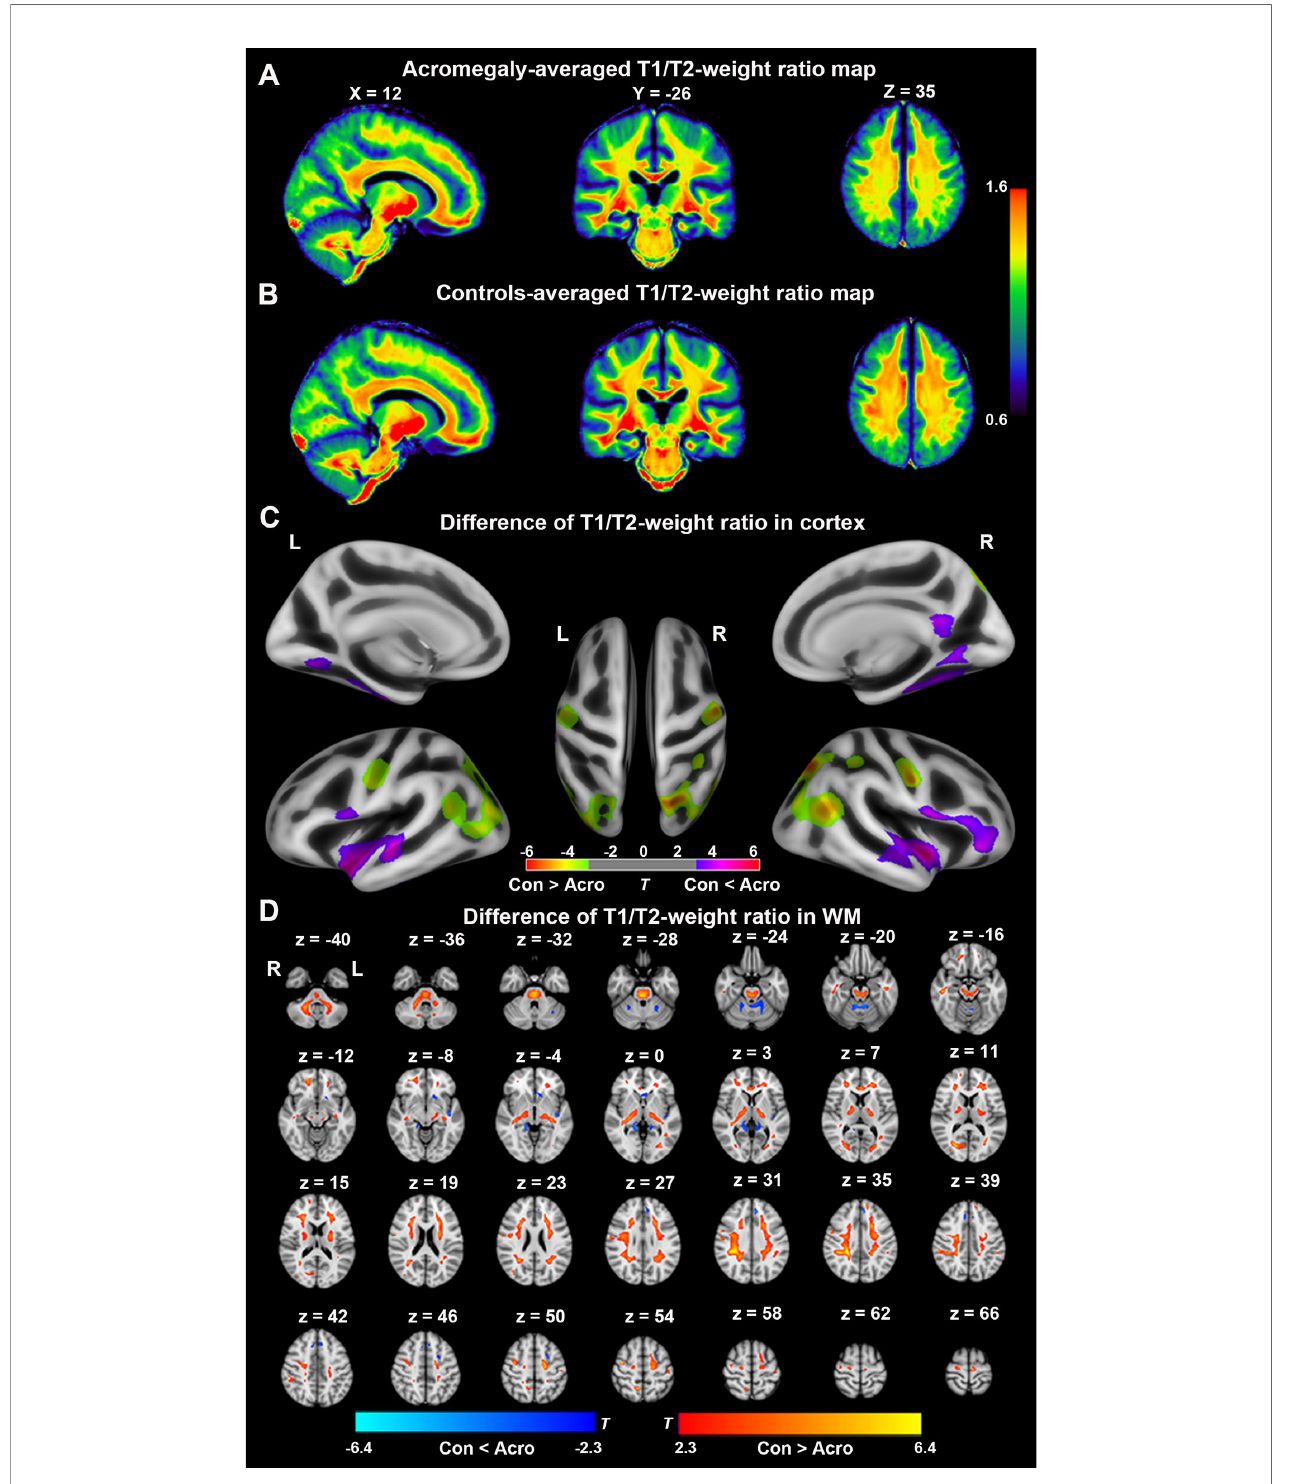
FIGURE 2 | Difference of T1/T2-weight ratio in cortex and white matter (WM) between acromegaly and controls. Average T1/T2-weighted ratio maps from acromegaly (A) and controls (B) . (C) Green-yellow indicates the T1/T2-weight ratio in cortex was signi fi cantly decreased in acromegaly compared to controls (pFDR < 0.05). Violet-red indicates the T1/T2-weight ratio in GM was signi fi cantly increased in acromegaly compared to controls (pFDR < 0.05) (D) Red-yellow indicates the T1/T2- weight ratio in WM was signi fi cantly decreased in acromegaly compared to controls (pFDR < 0.05). Blue indicates the T1/T2-weight ratio in WM was signi fi cantly increased in acromegaly compared to controls (pFDR < 0.05). Con, controls; Acro,